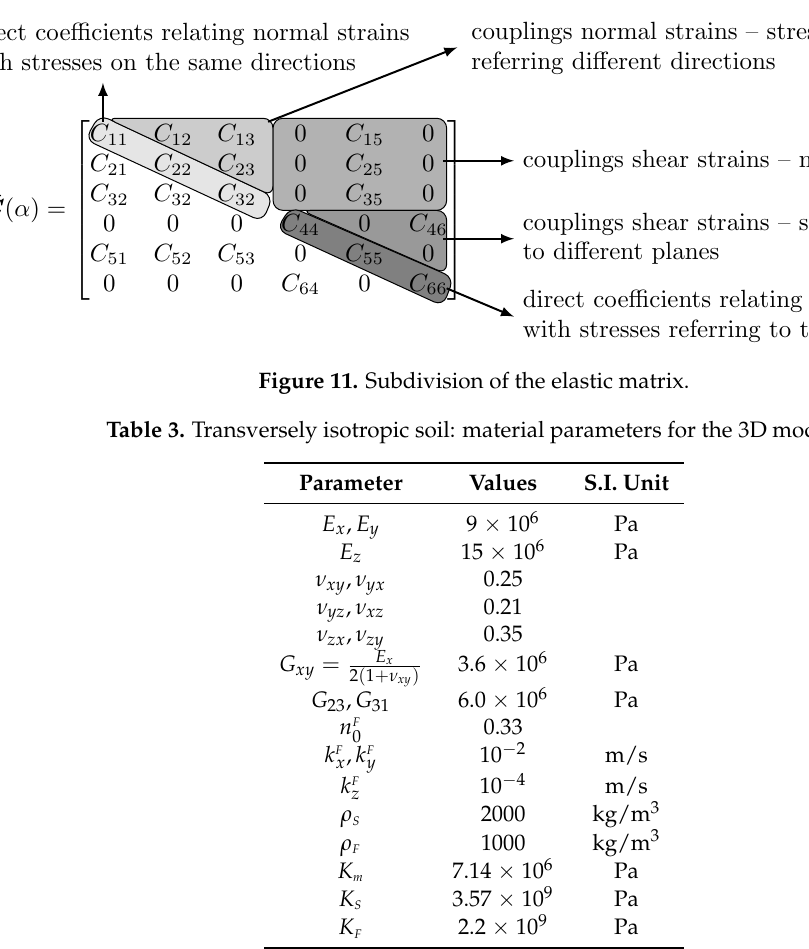
Figure 10. Schematic diagram of transversely isotropic soil models.